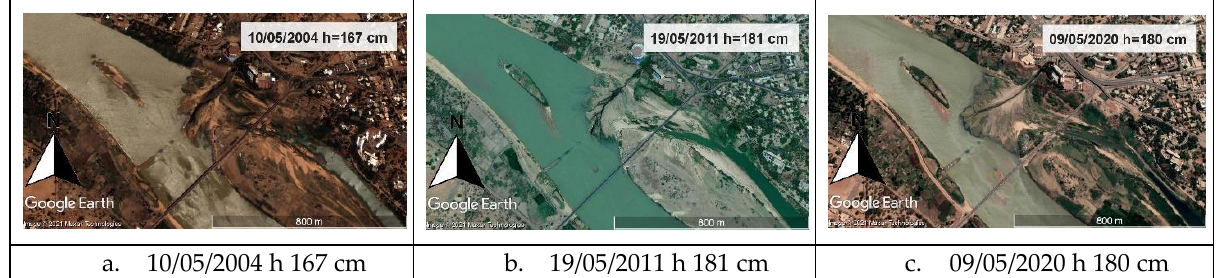
Figure 18. Evolution of the alluvial fan of the ‘ Palais de Congrès ’ channel (between the bar and the bridge).